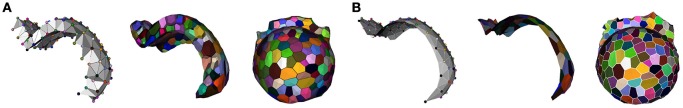
Layer reconstruction using adjacency complexes: L1-L2 tetrahedrization and its dual 2-layer 3D geometry (A) and L1 triangulation and its dual 2.5D geometry (B).